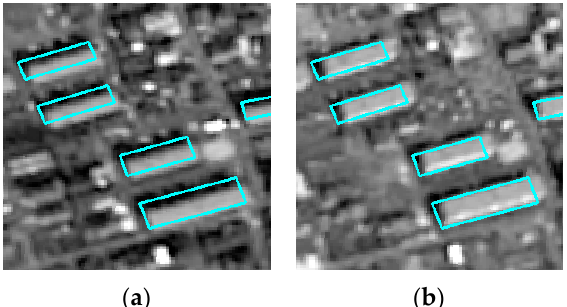
Figure 21. Examples of the roof position shifted due to different view angles and tall buildings drawn in blue outline on a: ( a ) 20 March 2016 SPOT image; and ( b ) 25 March 2018 SPOT image.